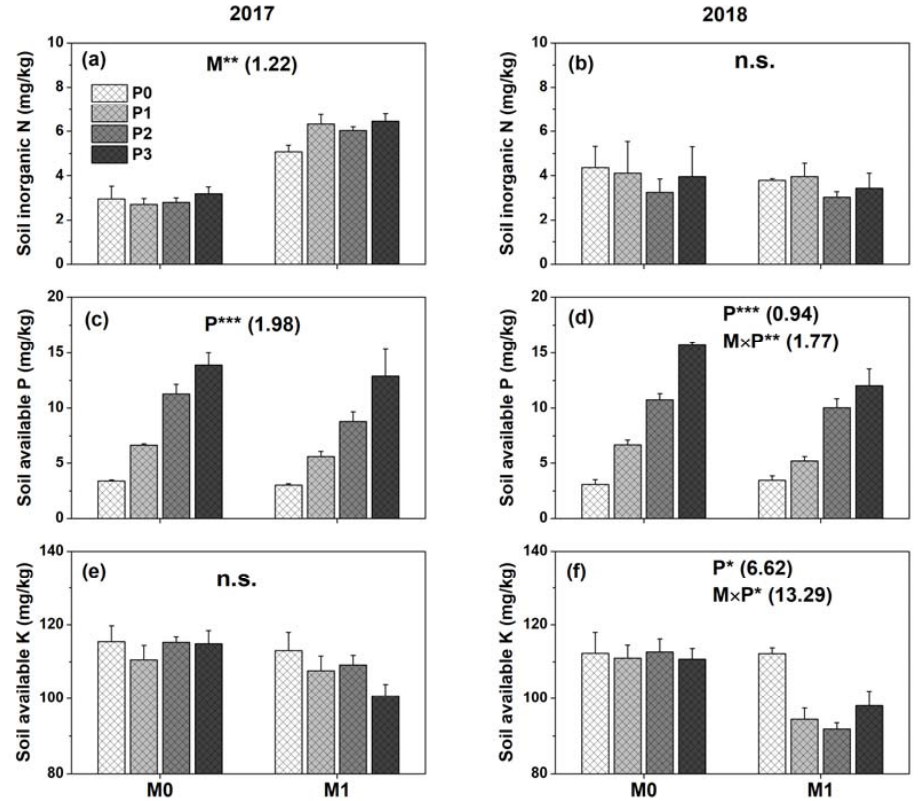
Figure 1. Effect of film mulch (M) and P fertilization (P) on ( a, b ) inorganic N, ( c, d ) available P, and ( e, f ) available K concentrations in soils in 2017 and 2018. M0P0, M0P1, M0P2, M0P3, M1P0, M1P1, M1P2, and M1P3 represent no mulch (M0) and mulch (M1) with four levels of P (P0, P1, P2, and P3), respectively. ***, p ≤ 0.001; **, p ≤ 0.01; *, p ≤ 0.05. Numbers in parentheses are the least significance differences (LSD) among treatments ( p = 0.05). Error bars show one standard error of the mean.